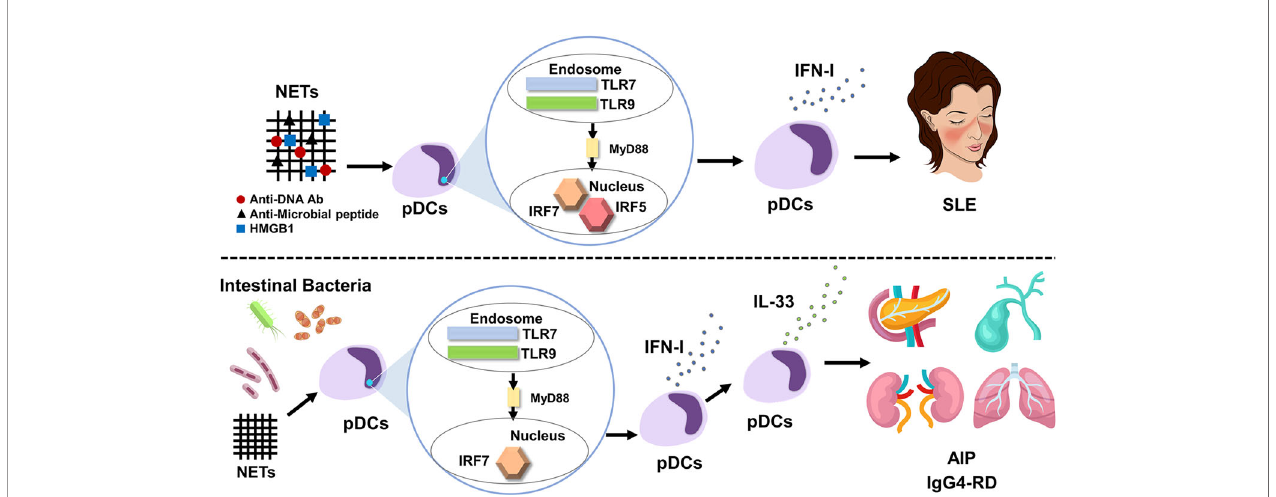
FIGURE 1 | IFN-I produced by plasmacytoid dendritic cells mediates systemic lupus erythematosus and autoimmune pancreatitis/IgG4-related disease. Neutrophil extracellular traps (NETs) activate plasmacytoid dendritic cells (pDCs) to produce large amounts of IFN-I. pDC-mediated IFN-I responses underlie the immunopathogenesis of systemic lupus erythematosus (SLE). Myeloid differentiation primary response protein 88 (MyD88)-dependent activation of Toll-like receptor 7 (TLR7) and TLR9 induces IFN-I production through nuclear translocation of interferon regulatory factor 5 (IRF5) and IRF7 (top panel). Intestinal dysbiosis and NETs activate pDCs to produce large amounts of IFN-I through nuclear translocation of IRF7, which, in turn, results in the enhanced production of IL-33 by pDCs. The pDC-IFN-I-IL-33 axis underlies the immunopathogenesis of autoimmune pancreatitis (AIP) and IgG4-related disease (IgG4-RD) (bottom